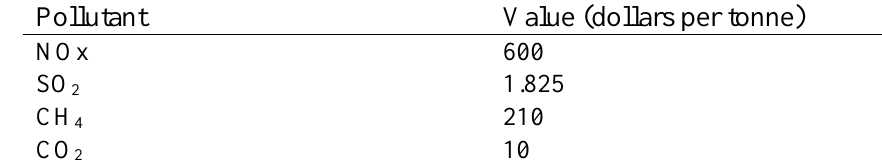
Table 5 . The values of profits from pollutant reduction for Iran, Shafipour et al